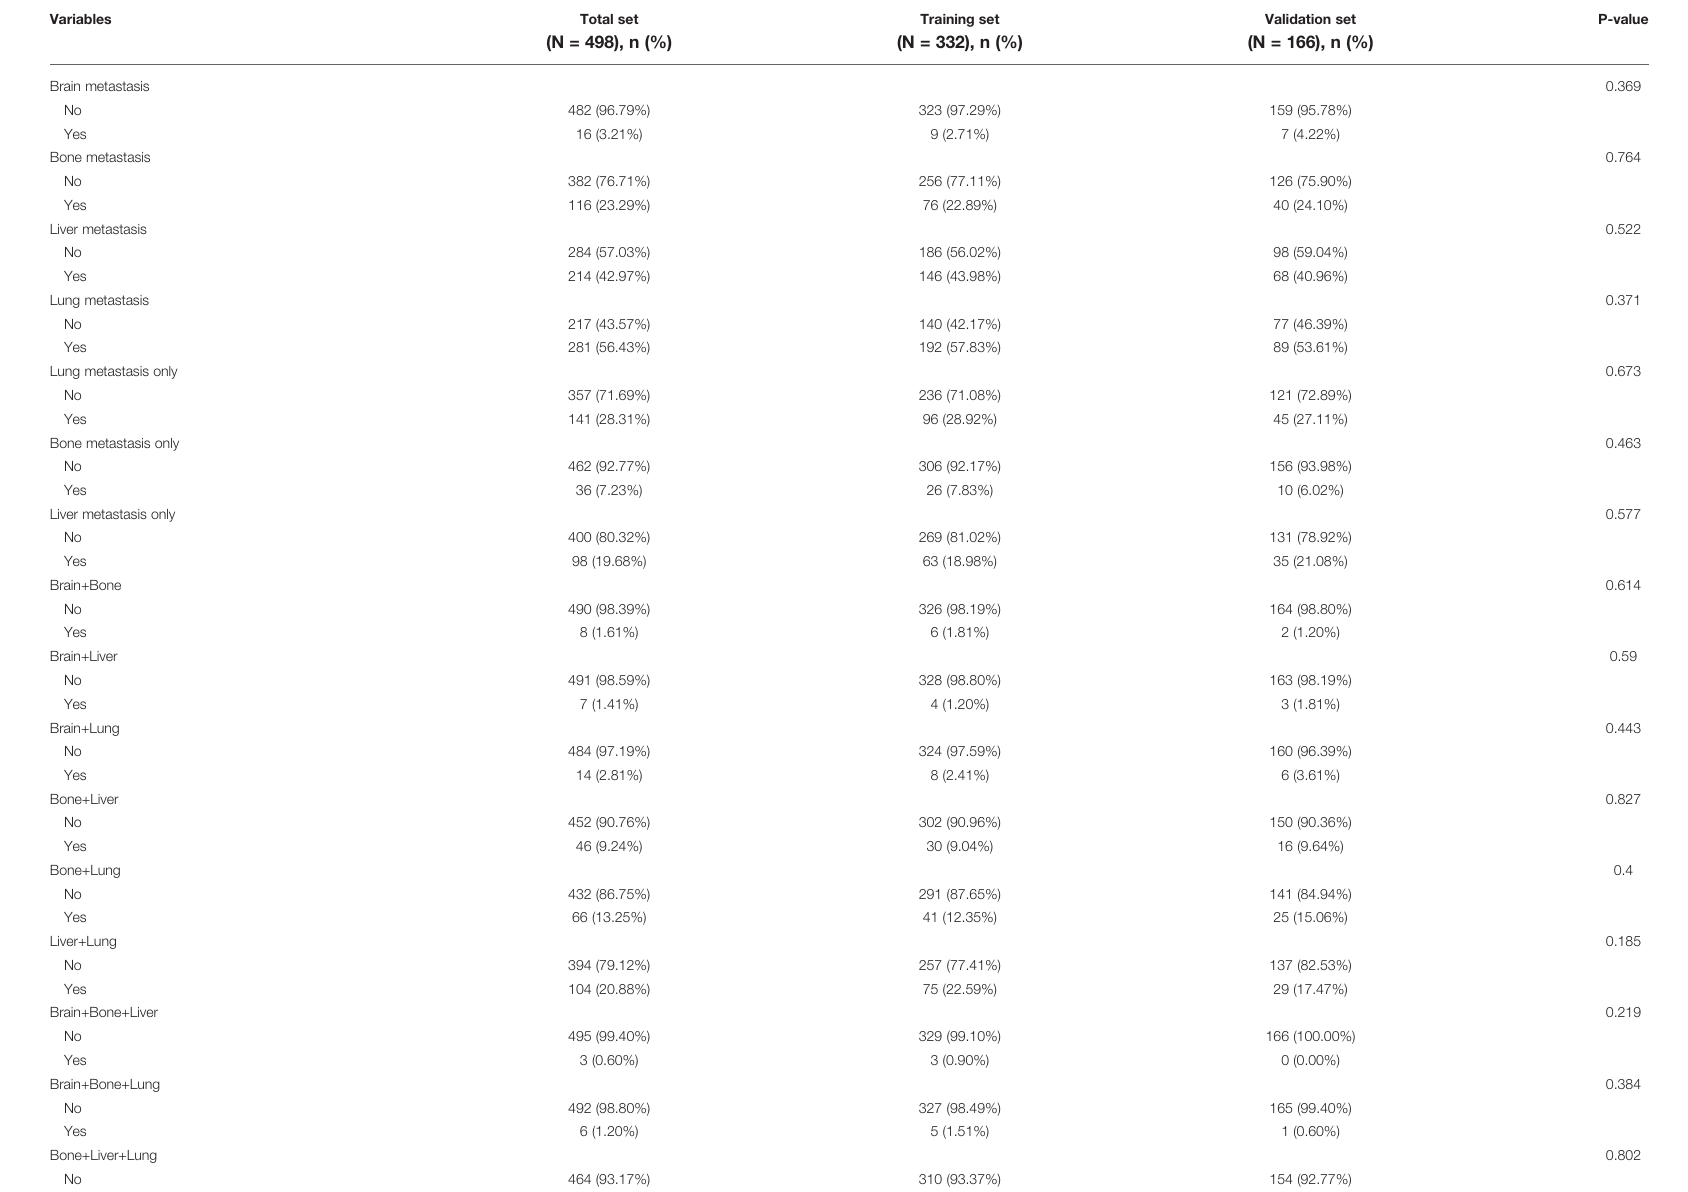
TABLE 2 | Baseline characteristics of metastasis in LMS patients in the whole dataset, training set, and validation